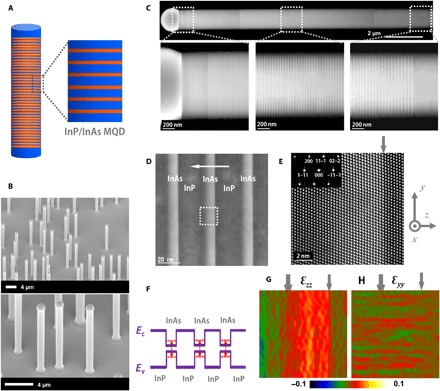
InP/InAs MQD nanowires.(A) Schematic diagram of MQD heterostructure nanowires and magnified view of the heterostructure highlighting the InP/InAs MQD structure. The InAs layer is indicated in red. (B) SEM images (tilt, 38°) of InP/InAs MQD nanowires grown on InP (111)B substrate. A particle can be seen at each nanowire tip. The nanowire diameters are 0.9 to 1.2 μm. The nanowire lengths are 9 to 12 μm. (C) HAADF-STEM images of an InP/InAs MQD nanowire taken along the [011] zone axis. The nanowire contains 400 units of InP/InAs heterostructure. (D and E) Aberration-corrected HAADF-STEM images of InP/InAs heterostructures taken along the [011] zone axis. The horizontal white arrow indicates the growth direction. The thickness of an InAs layer and an InP barrier layer are 9.0 ± 1 and 25.6 ± 1 nm, respectively. The square dotted region in (D) is shown in (E) with high resolution. The dislocation-free InAs/InP interface indicates a coherent growth despite a 3.1% lattice mismatch of InAs/InP. (F) Schematic band diagram of InP/InAs heterostructure nanowires with three InAs QDisks. The thickness as thin as ~9 nm of an InAs QDisk causes quantum confinement effect along the axial direction and thus increases the real gap energy compared with the bulk InAs gap energy (0.36 eV at 300 K), as indicated by red dotted lines. (G and H) Strain mapping of lattice spacing difference along the y and z directions for the STEM image shown in (E), indicating a compressive strain inside the InAs QDisk active region. The gray arrows indicate the InP/InAs interfaces.